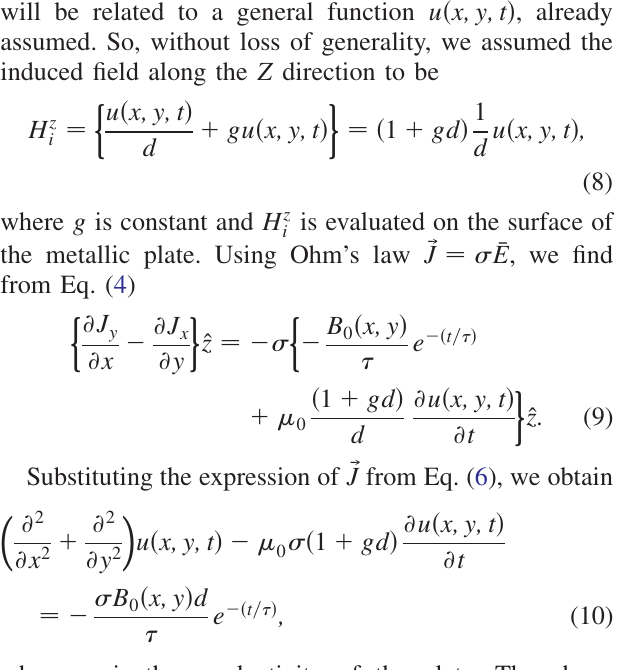
FIG. 4. Coordinate system, geometry of the chamber and the direction of the forces ( F 1 and F 2 ) is shown. Here the chamber is exposed to a magnetic field that varies both in space and time (case